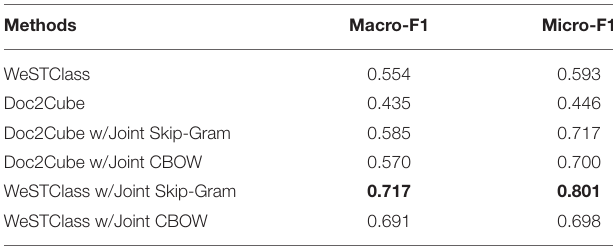
TABLE 8 | Weakly-supervised text classification on